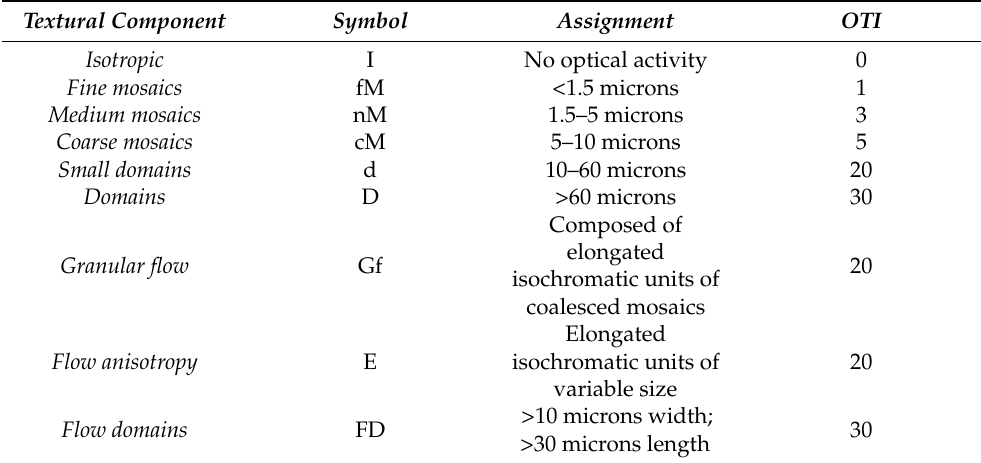
Table A1. The classification of the textural component at each